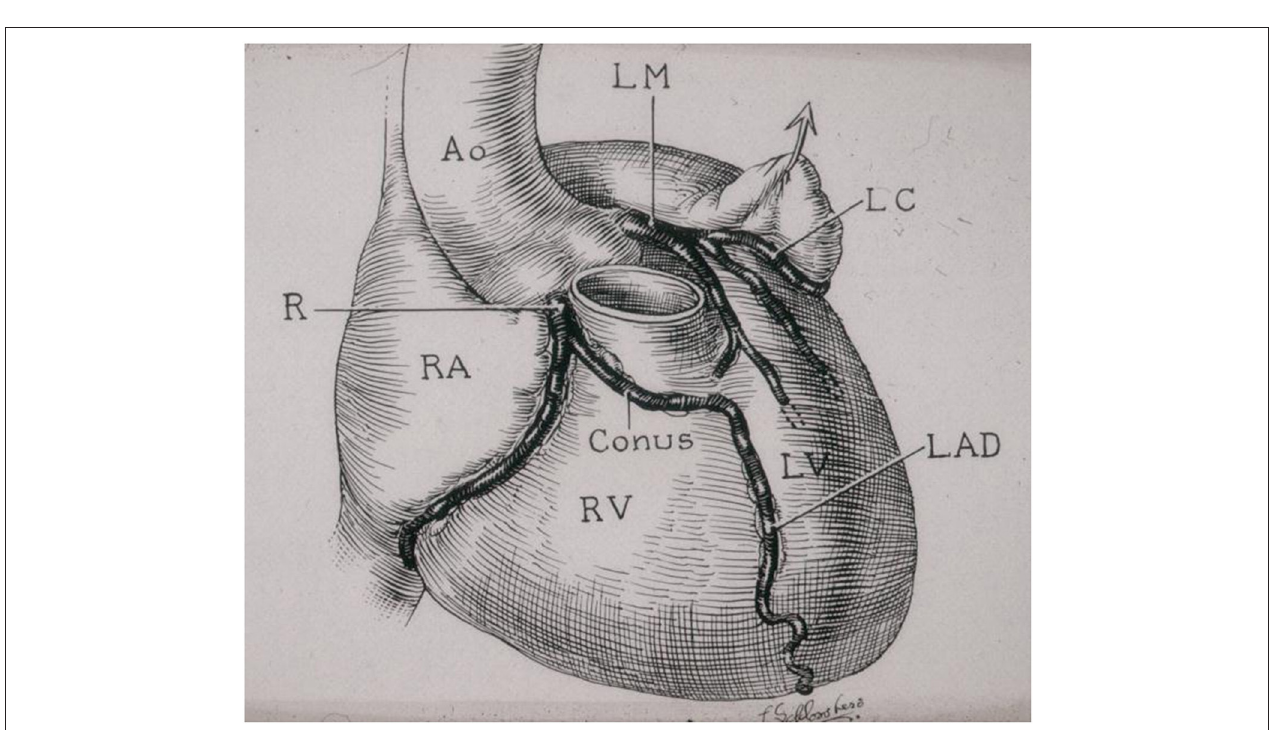
FIGURE 11 | Origin of the left anterior descending coronary artery from the right coronary artery. Note the anomalous proximal course in front of the pulmonary infundibular. From Roberts (6).